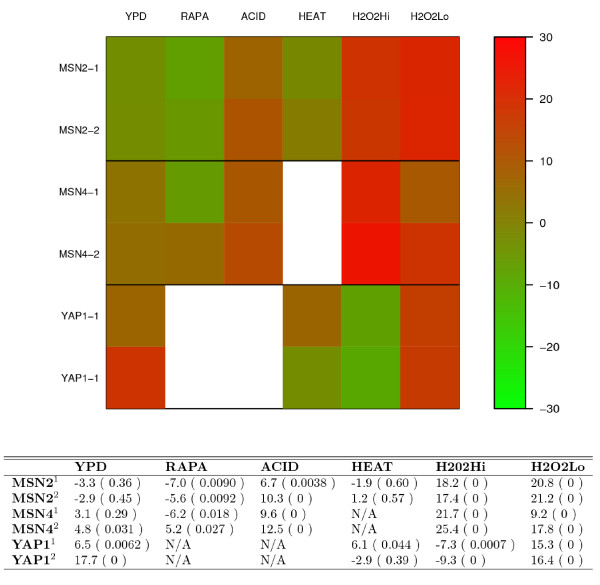
Consistency of inferred AC scores for TFs in the corresponding over-expression TFPEs. The upper image shows the AC scores for Msn2, Msn4, and Yap1 inferred from two independent over-expression TFPE data in combination with ChIP-chip data from different conditions. The lower table shows the AC scores as well as the significance levels (in bracket). Rows are different TFPEs for the corresponding TF and columns are different conditions under which the ChIP-chip data for the corresponding TF is measured. The superscript in the first column distinguishes the two independent gene expression profiles. N/A means not available, which is due to the unavailability of the ChIP-chip data for the TF under the condition.